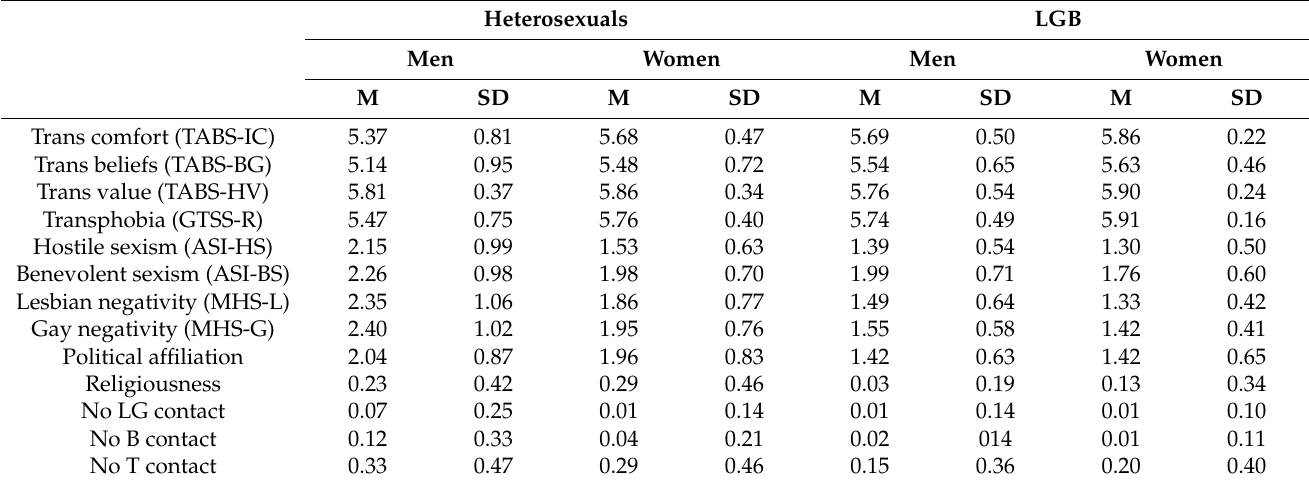
Table 1. Means and Standard Deviations by Gender Identity and Sexual Orientation.